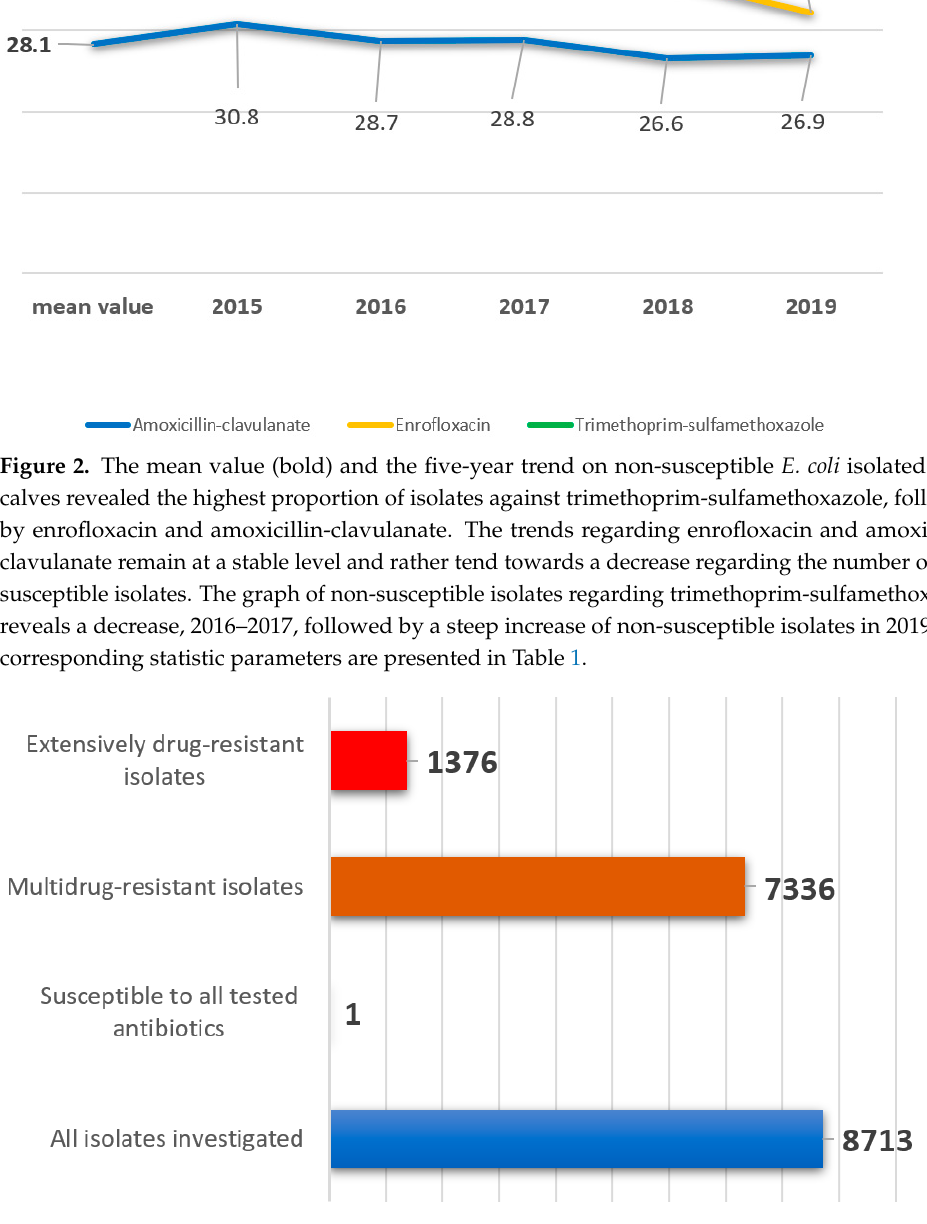
Figure 3. The classification of 8713 E. coli into extensively drug-resistant and multi drug-resistant isolates was carried out according to the expert proposal for standard definitions for acquired resistance. We categorized eight potential pandrug-resistant isolates in the category extensively drug resistant, as we only tested antimicrobials licensed for the veterinary use and did not include the latest antimicrobials available on the market.